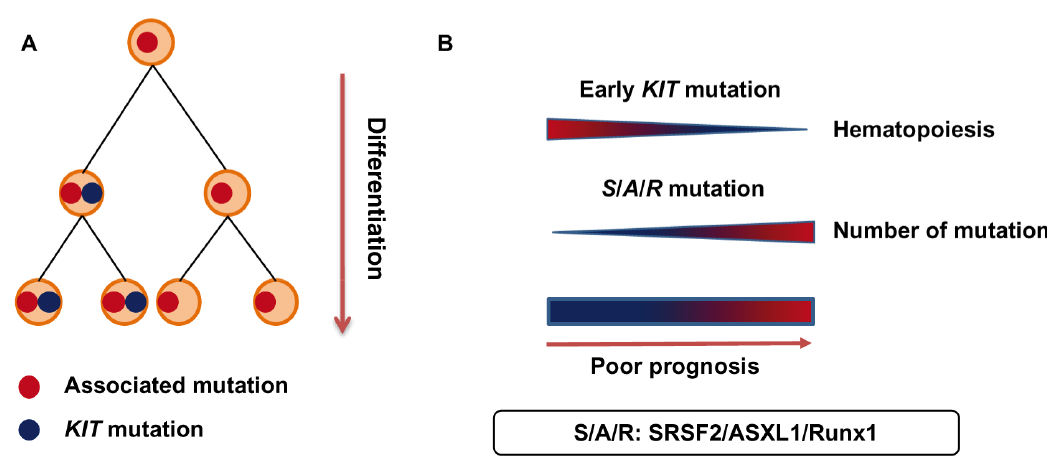
Figure 2. Advanced systemic mastocytosis: clonal architecture and prognosis. A . A representation of the clonal architecture of the hematopoietic compartment in advanced mastocytosis. The associated mutations occur before the KIT mutation. B . An early D816V KIT mutation inside the hematopoietic progenitor compartment and the presence of SRSF2, ASXL1, RUNX1 (S/A/R) mutations are associated with a poor outcome. A, ASXL1 mutation; R, RUNX1 mutation; S, SRSF2